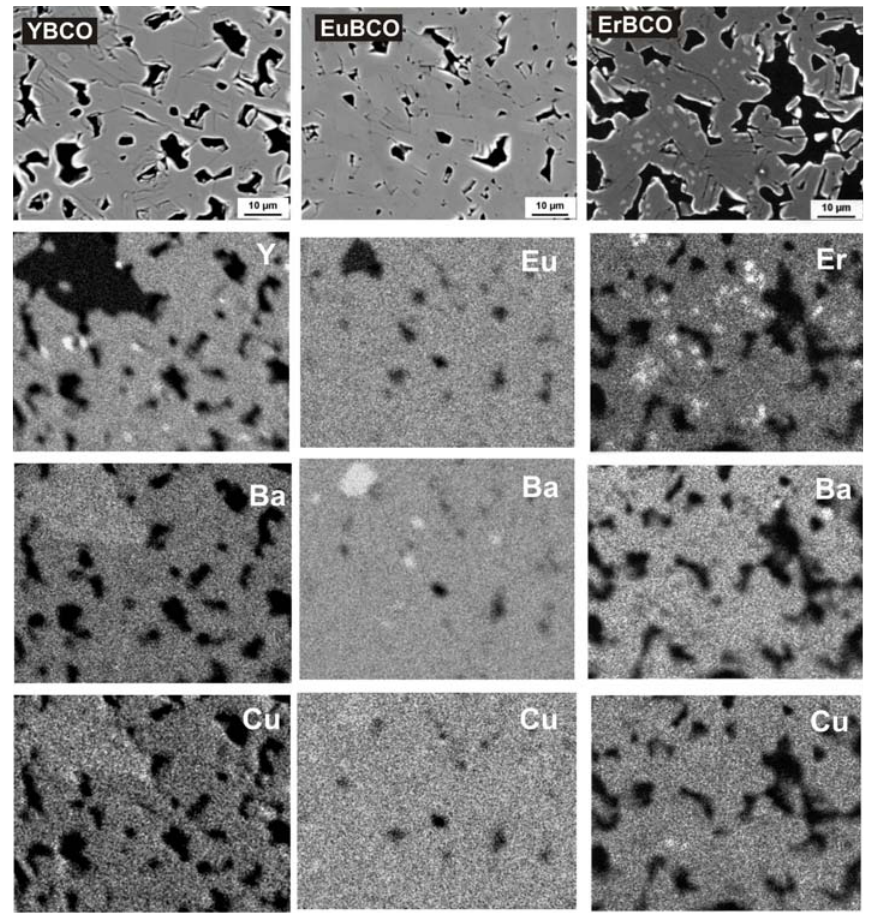
Fig. 2 Backscattering electron image of RE samples, showing the composition map of different